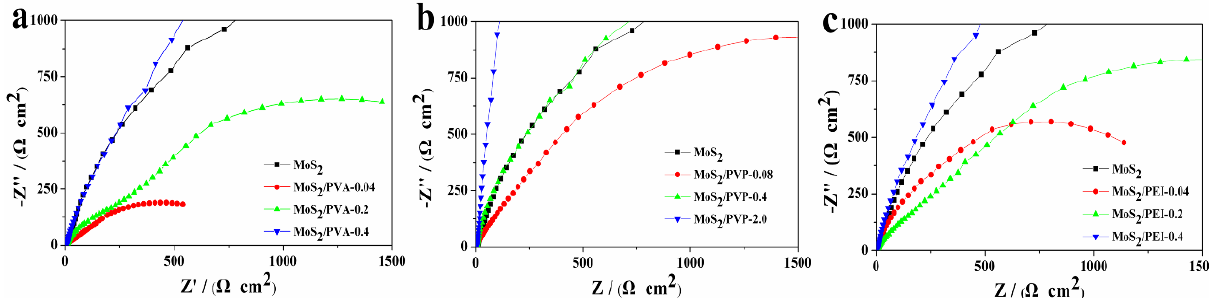
Figure 8. Nyquist plots of MoS 2 -based nanoflower-like composite catalysts: ( a ) MoS 2 /PVA composite; ( b ) MoS 2 /PVP composite; ( c ) MoS 2 /PEI